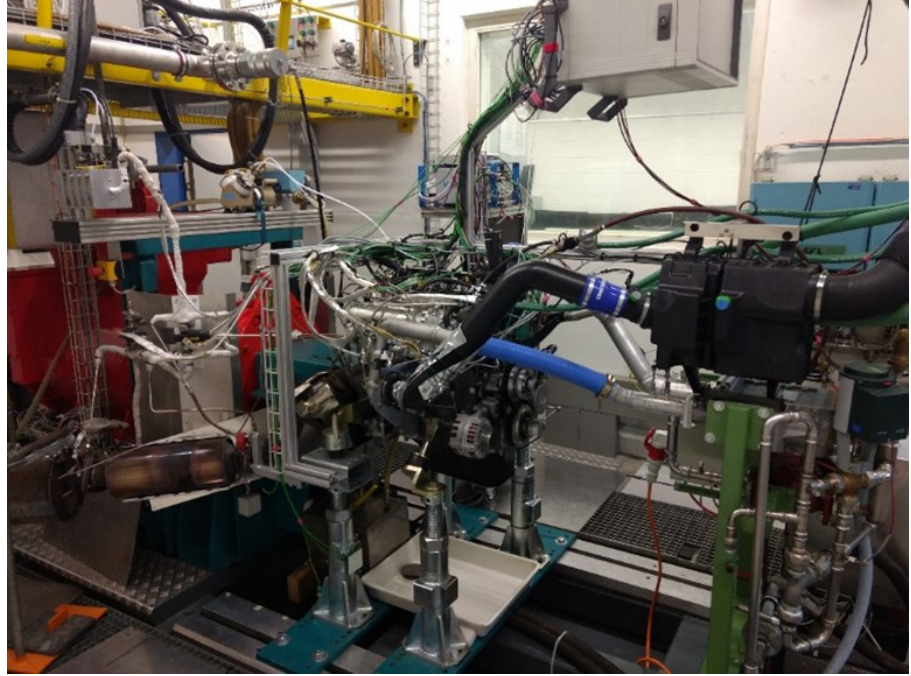
Figure 1. Test bench